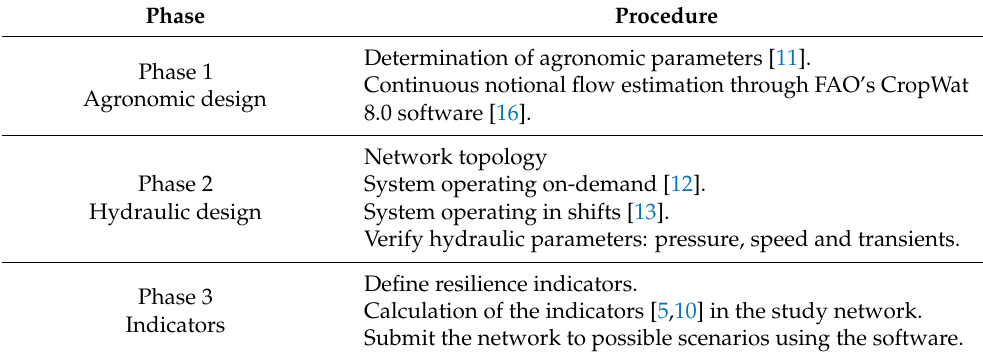
Table 1. Methodology